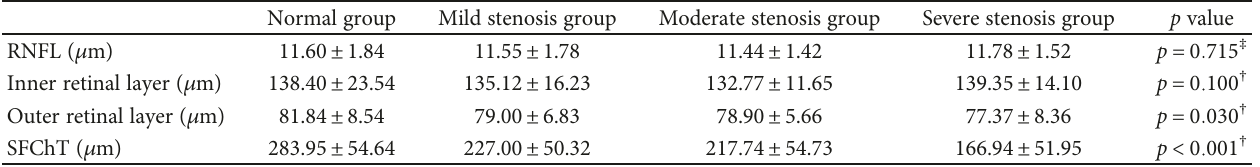
Table 4: Retinal thickness and the subfoveal choroidal